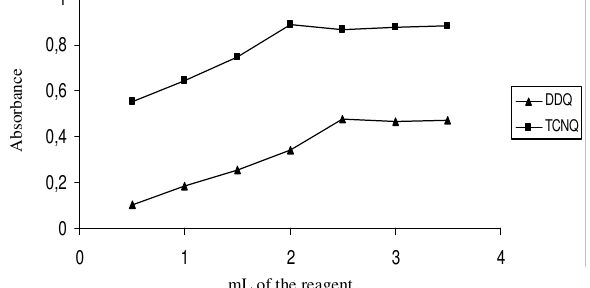
Figure 3. Effect of volume of DDQ, (0.2%, w/v) and TCNQ (0.2%, w/v) on the development of the reaction product of DLX with these reagents at ( ▲ ) DDQ and ( ■ ) TCNQ.